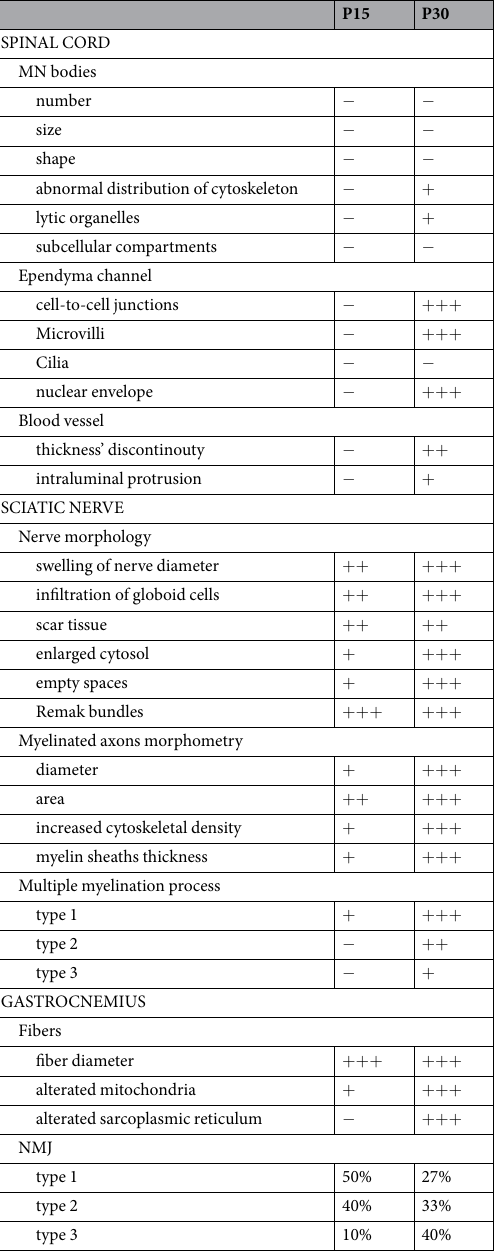
Table 1. Comparison between early and late pathological stages in the lower motor system of TWI mice compared with WT littermates ( − absence of signs; + mild differences; ++ medium differences; +++ severe